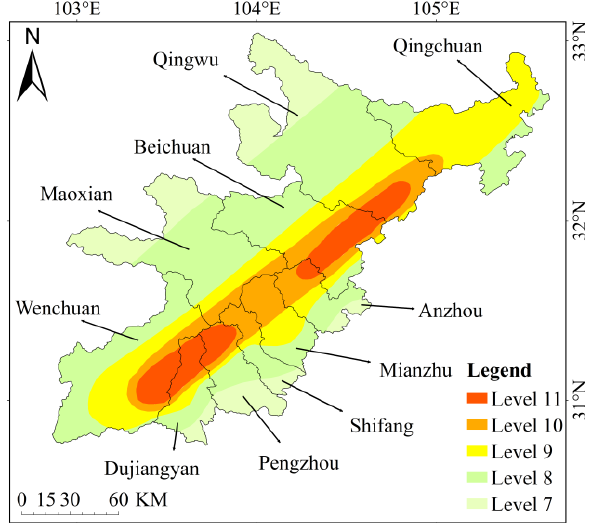
Figure 2. Seismic intensity division map of the research area.